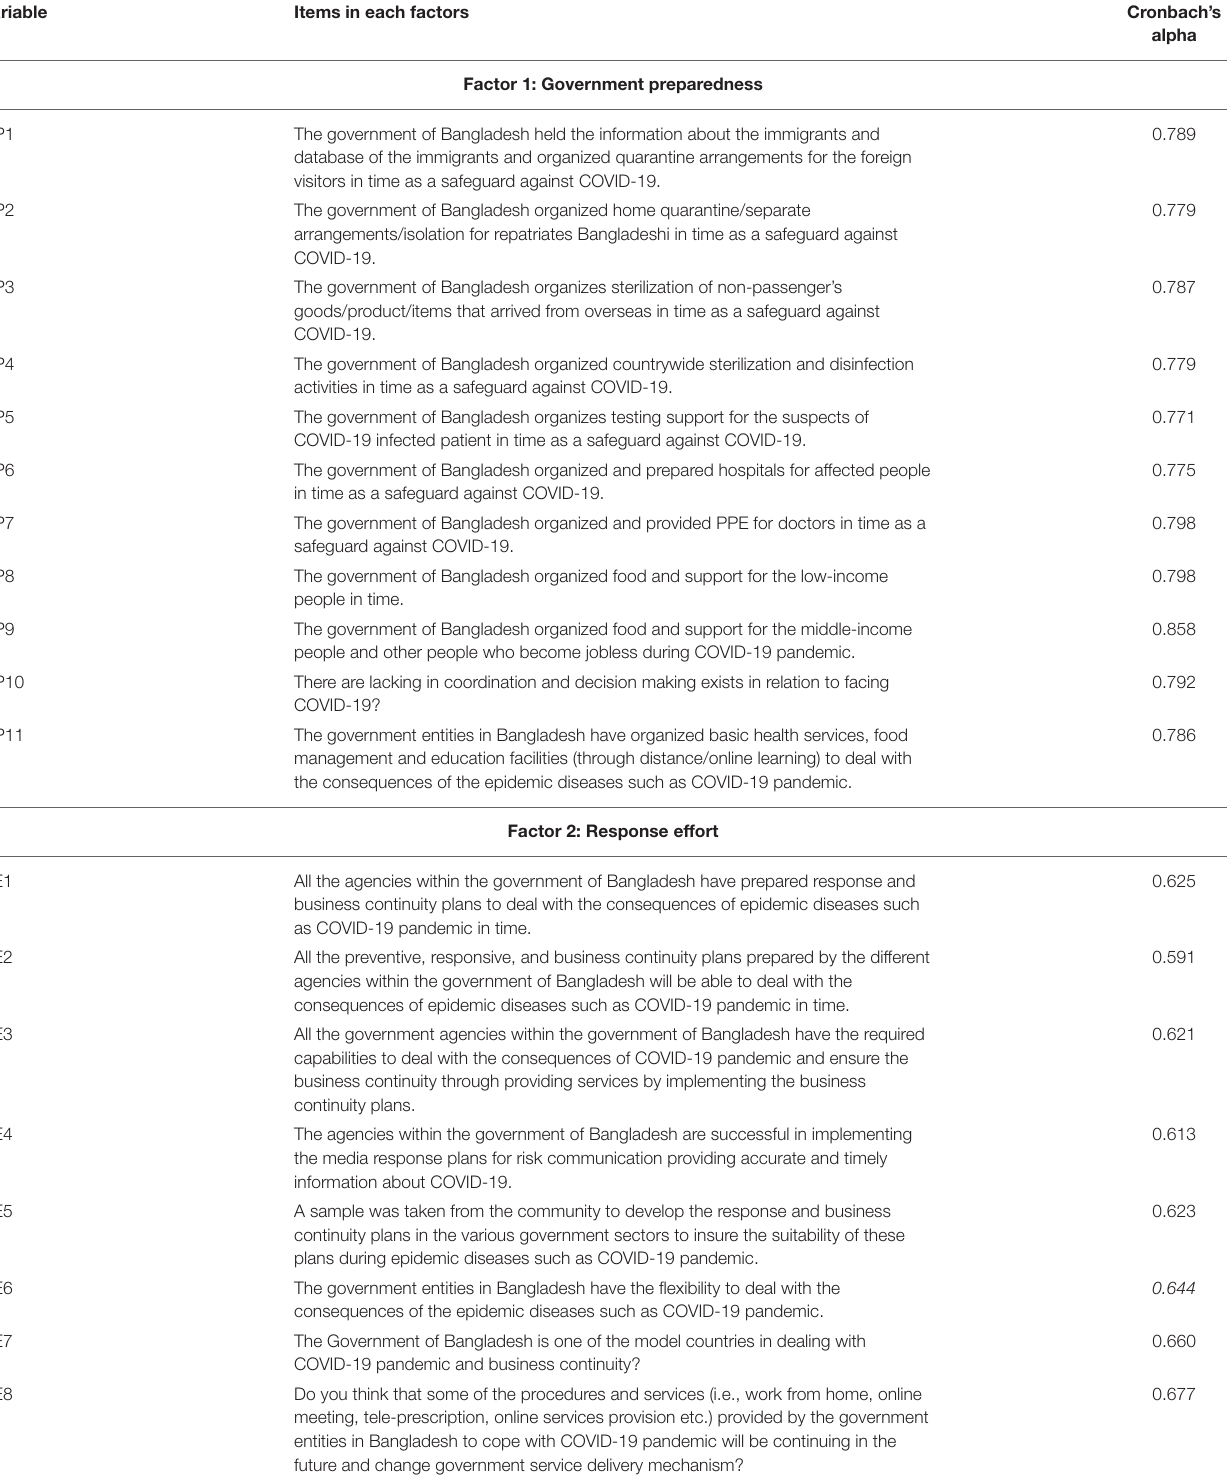
TABLE 1 | Items in each factor and their internal reliability. Variable Items in each